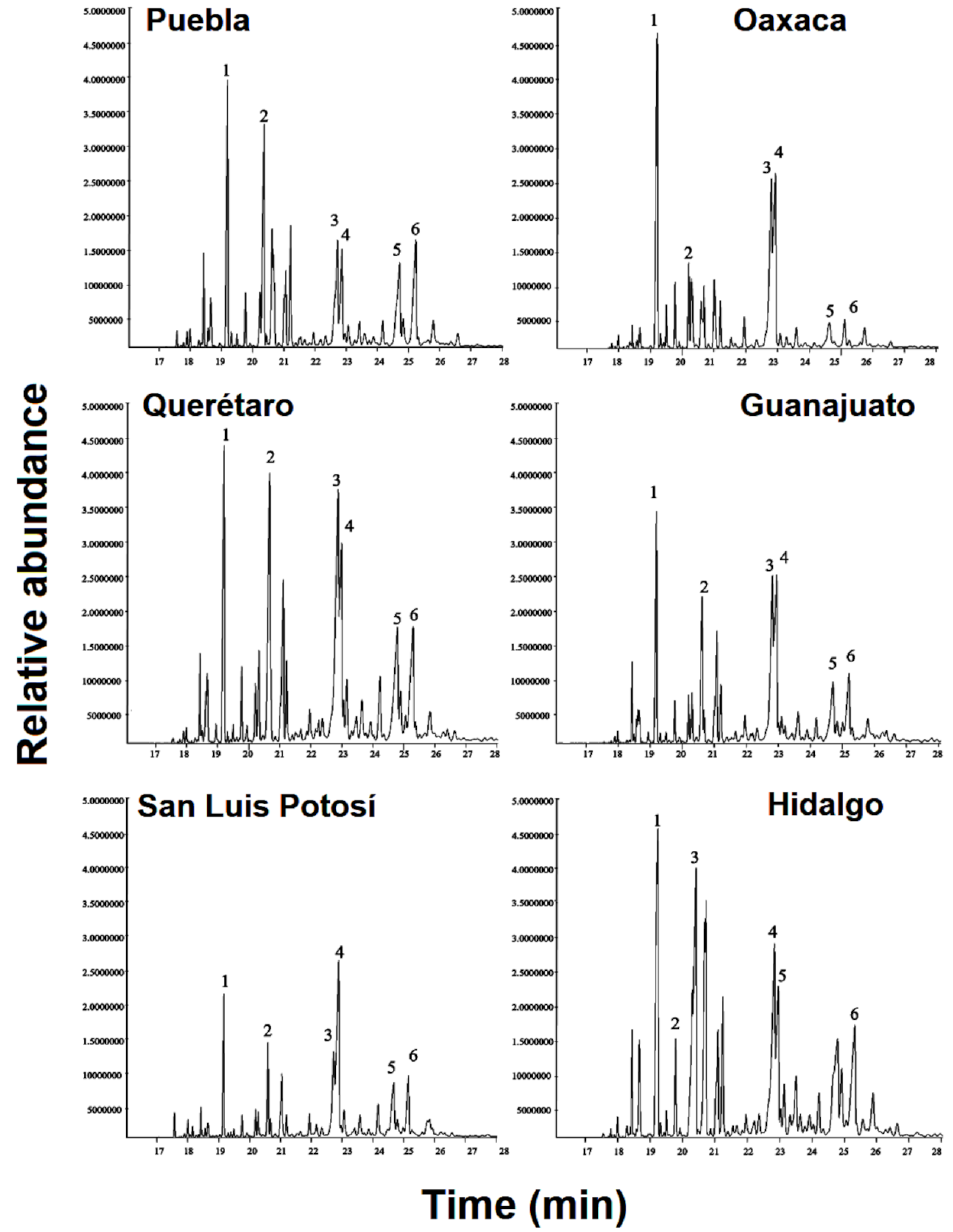
Figure 7. Total ion current of GC-MS showing the six major volatiles of the essential from B. veronici- folia . (1) β –caryophyllene, (2) cubedol, (3) spathulenol, (4) caryophyllene oxide, (5) tau-Muurolol and (6) α –cadinol